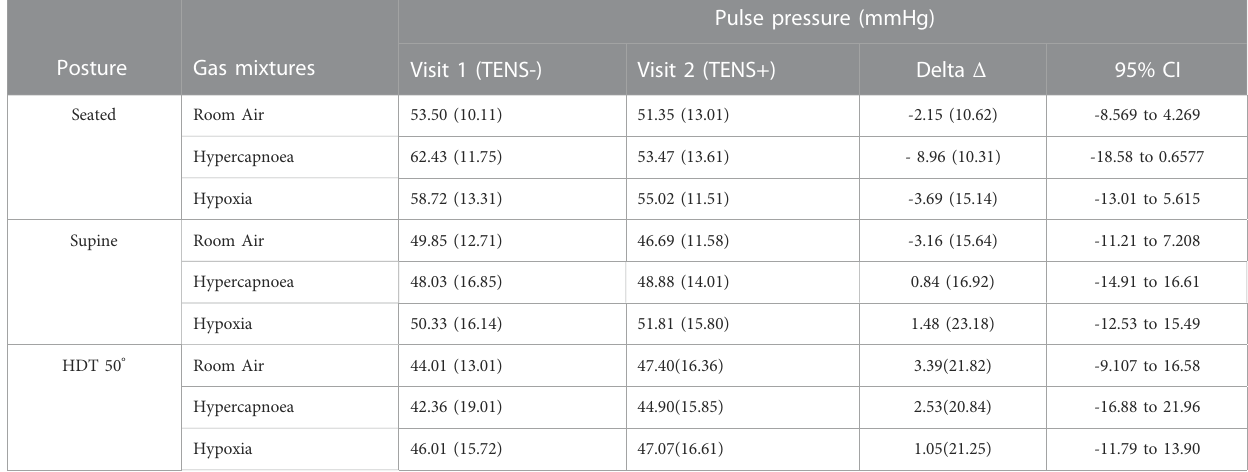
TABLE 4 Pulse Pressure with and without electrical stimulation in seated, supine and HDT postures. Data are presented as mean (SD). HDT, head down tilt. TENS-, electrical current off. TENS + electrical current turned on. CI, 95% con fi dence interval.